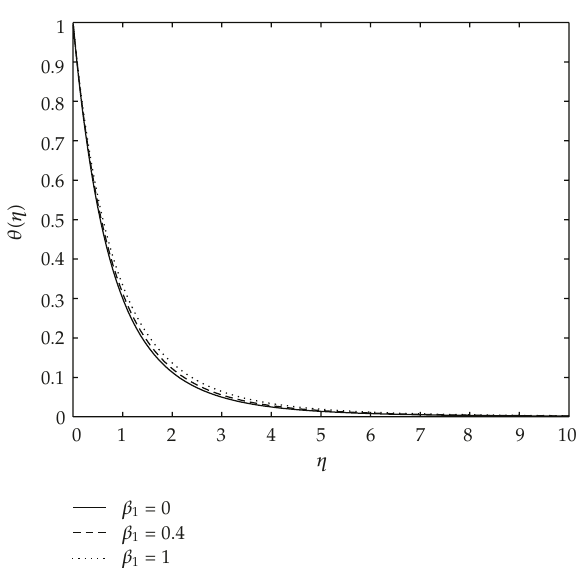
Figure 9: Temperature profiles for various values of β 1 with M (cid:5) 1, Pr (cid:5) 0 . 72, m (cid:5) 1, β 2 (cid:5) 0 . 1, and S (cid:5) 0 . 8 .